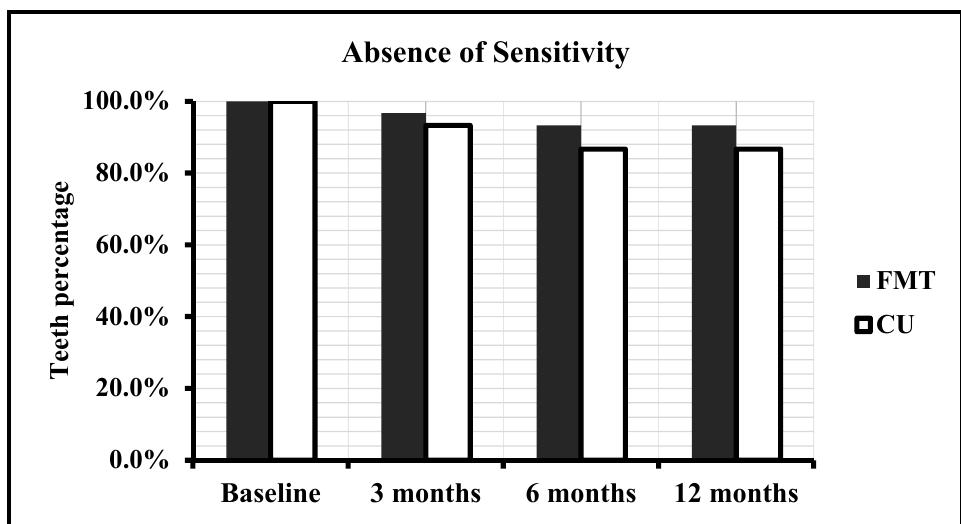
Figure 3. Absence of sensitivity in restored teeth with FMBT and CULT over time.